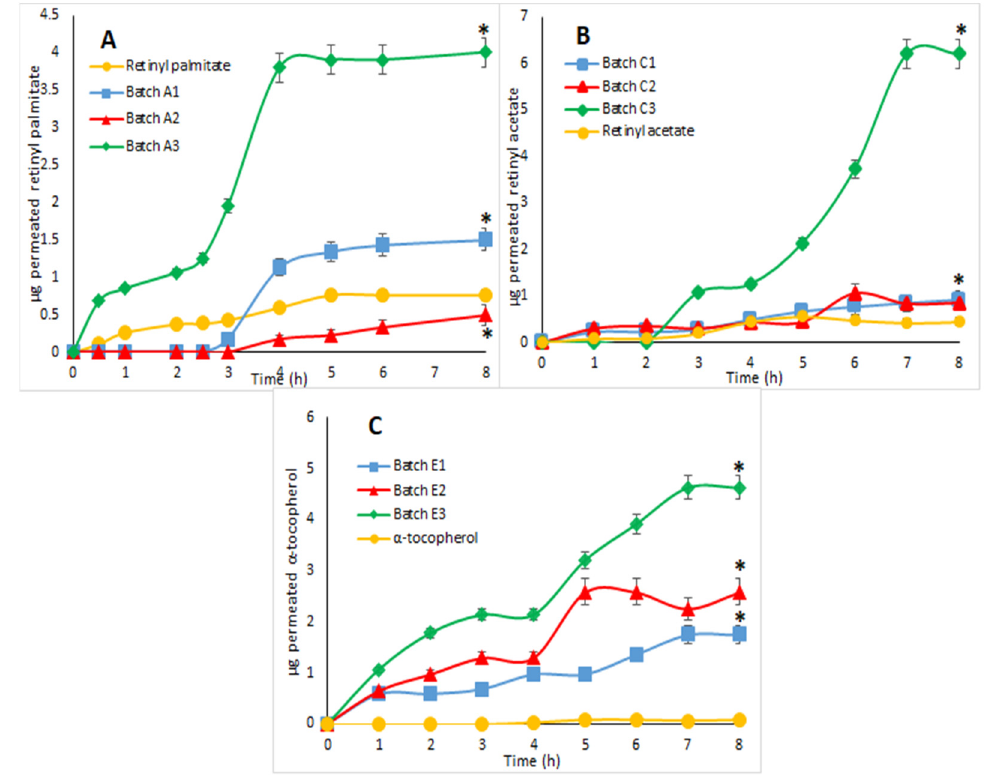
Figure 7. Amount ( µ g) of permeated vitamin as a function of time: ( A ) retinyl palmitate, batches A1, A2, A3 and pure retinyl palmitate; ( B ) retinyl acetate, batches C1, C2, C3 and pure retinyl acetate; ( C ) α -tocopherol, batches E1, E2, E3 and pure α -tocopherol (mean ± SD, n = 3). p < 0.05 (*) for all tested batches versus pure vitamins after 8 h.